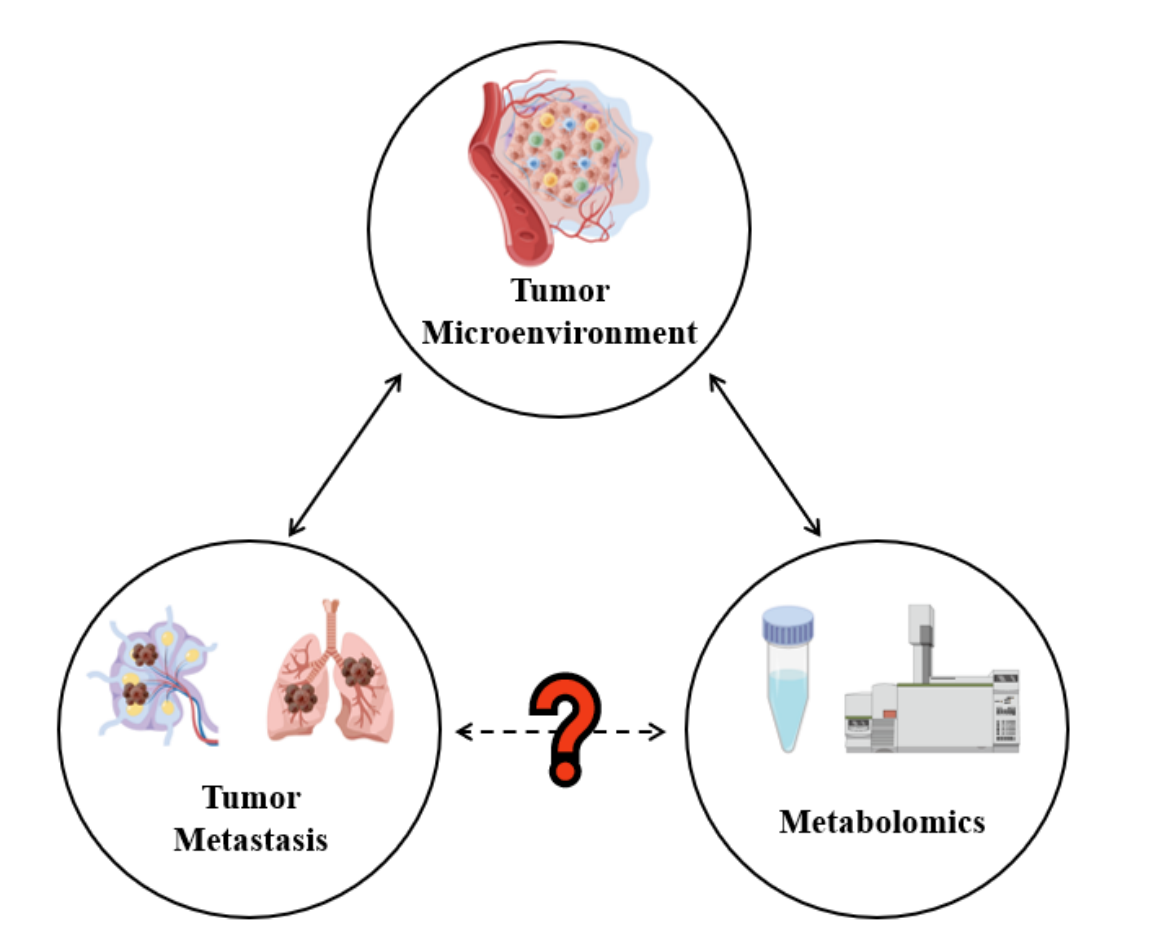
Figure 1. Correlations between tumor microenvironment (TME) evolution, tumor metastatic status, and metabolomics characteristics. TME will lead to tumor metastasis and invasion, and changes in the TME will also lead to changes in serum metabolite levels. The correlation between the content of metabolites and the degree of tumor metastasis was intended to be established based on the above correlations.